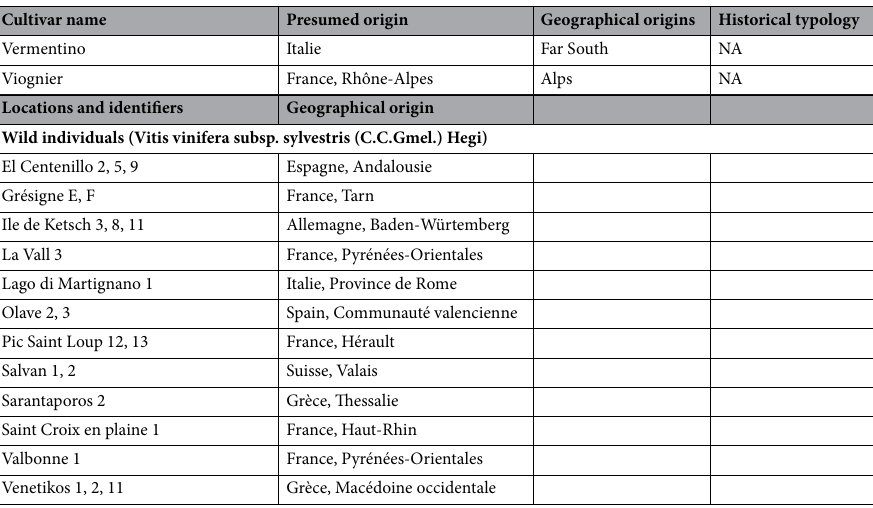
Table 1. List of wild individuals and domesticated varieties in the modern reference collection. Geographical origins and historical typology are derived from Thierry Lacombe (2012). All varieties are wine varieties with the exception of “Chasselas” and “Clairette”, which have mixed table/wine uses. NA indicates non available information. Wild individuals are provided with their location and alphanumerical identifiers.